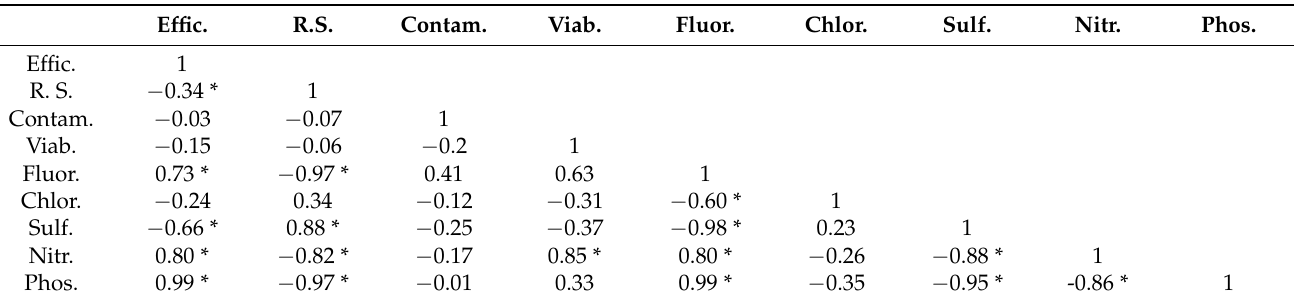
cantly correlated. Fluoride was positive and significantly correlated with nitrate ( p = 0.01) and phosphate ( p < 0.01) contents and negatively correlated with chloride ( p = 0.02) and sulfate ( p = 0.01) contents. Nitrate was negative and significantly correlated with sulfate ( p = 0.01) and phosphate ( p < 0.01). Sulfate and phosphate were negatively correlated ( p < 0.01) (Table 5). Table 5. Correlations between the characteristics of the fermented substrates characteristics of corn ethanol (CT) and corn ethanol integrated with energy cane (PT) and fermentation efficiency. Effic. R.S. Contam. Viab. Fluor. Chlor. Sulf. Nitr.